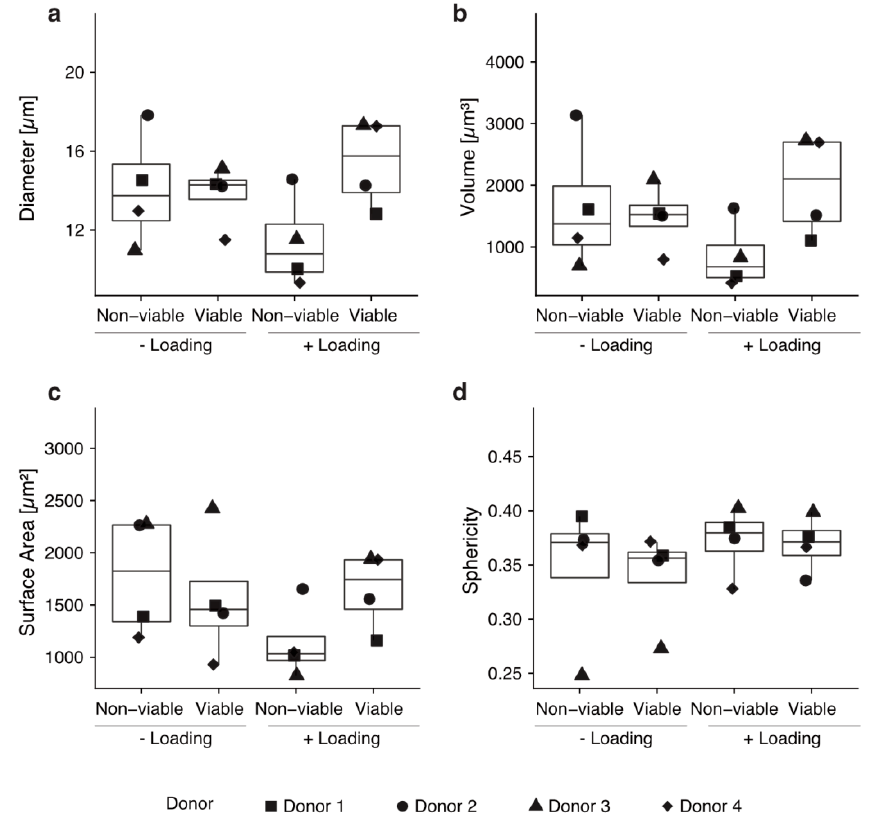
Figure 4. Cells that mobilized into the sca ff olds by mechanical loading show no morphological changes. No statistically significant morphological changes were observed regarding diameter ( a ), volume ( b ), surface area ( c ) or sphericity ( d ) by performing a Wilcoxon rank sum test. Every condition was tested with technical triplicates of hBM-MSCs from four di ff erent donors.